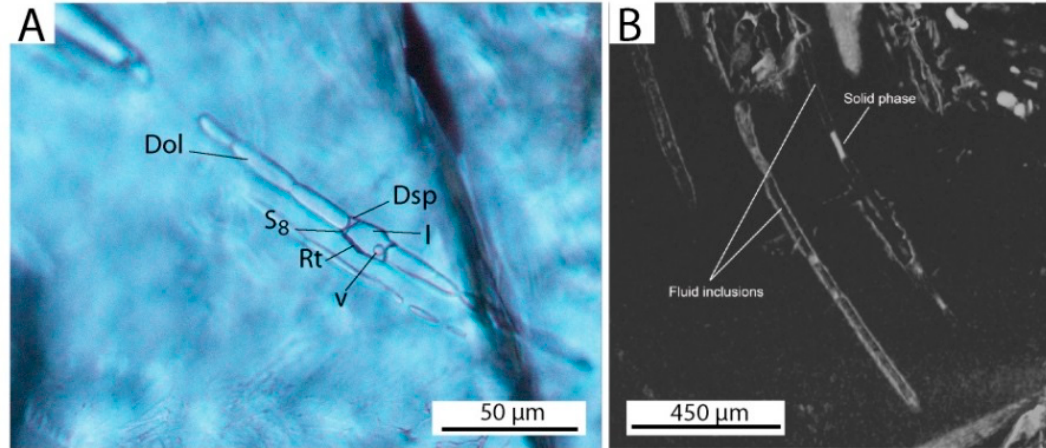
Figure 13. Solid and fluid inclusions trapped by trapiche rubies. ( A ) Primary fluid inclusions trapped along the sector boundary of a trapiche ruby from Mong Hsu, Myanmar. The fluid inclusion was trapped within tube-like structures formed by dolomite (Dol). It is a multi-phase fluid inclusion containing a two-phase (liquid + vapor) CO 2 -H 2 S-S 8 -bearing fluid and minerals including diaspore (Dsp) and rutile (Rt). V = vapor phase, l = liquid phase; from [62]. Photo: Gaston Giuliani; ( B ) X-ray computed tomography image of a trapiche ruby from Luc Yen, north Vietnam, showing tube-like voids that contain solid and fluid inclusion cavities; from [57]. Photo: Christophe Morlot.